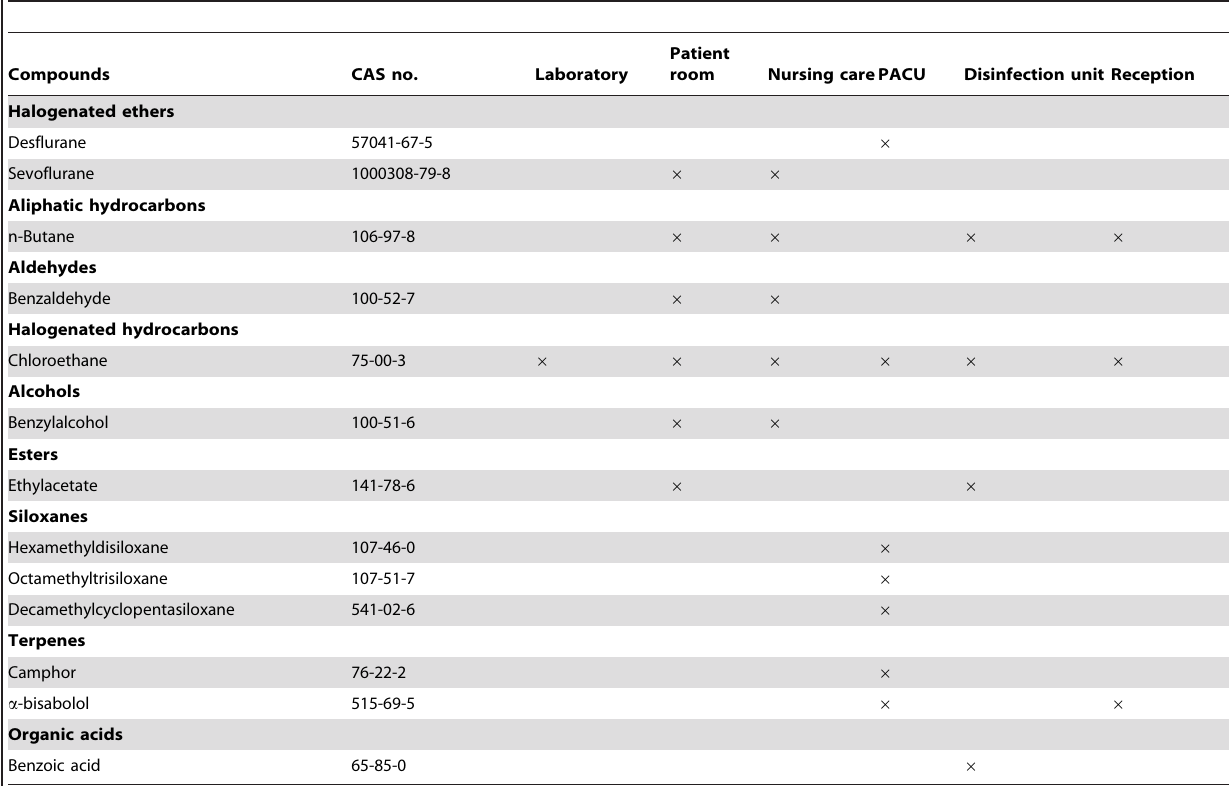
Table 5. Other compounds identified (CAS number) in at least one air sample in the parasitology laboratory, the patient room, the nursing care, the post-anesthesia care unit (PACU), the flexible endoscope disinfection unit and the reception.